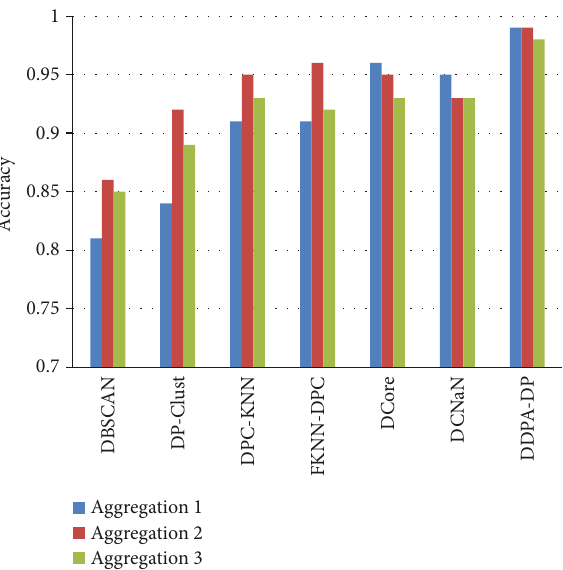
Figure 18: The simulation results in